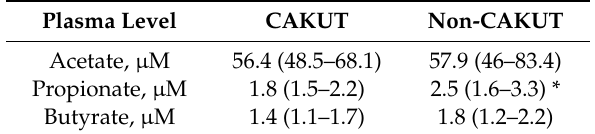
Table 3. Plasma levels of acetate, propionate, and butyrate in children with